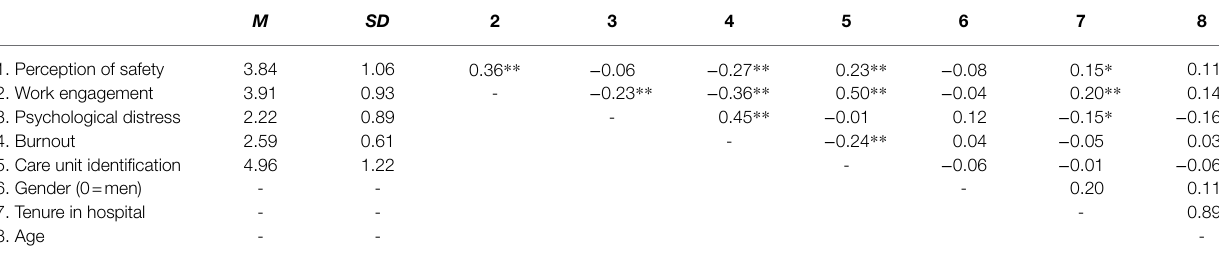
TABLE 1 | Descriptive statistics and zero-order correlation of measures.